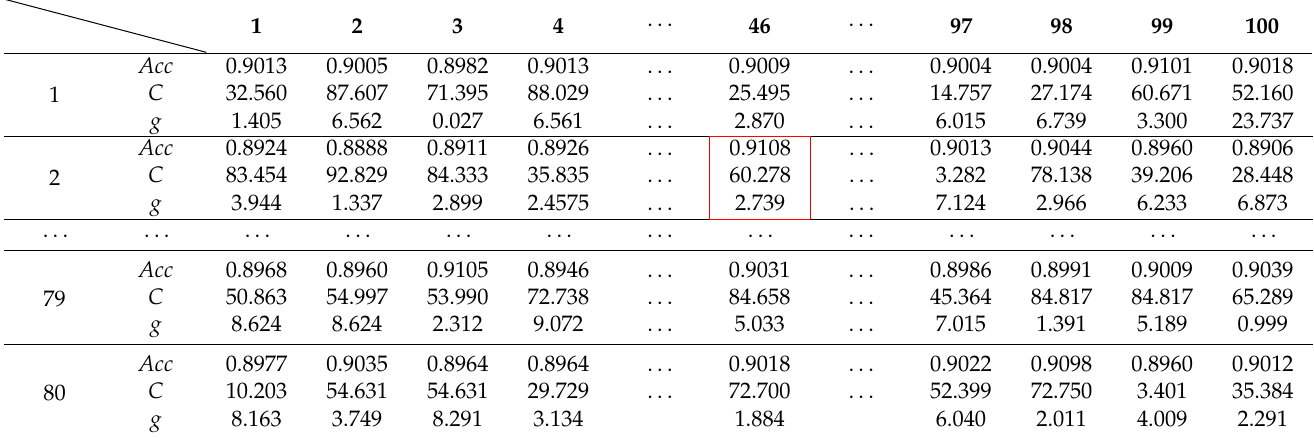
Table A2. Process data during the training of a certain GA-SVM base classifier f t ( x ).